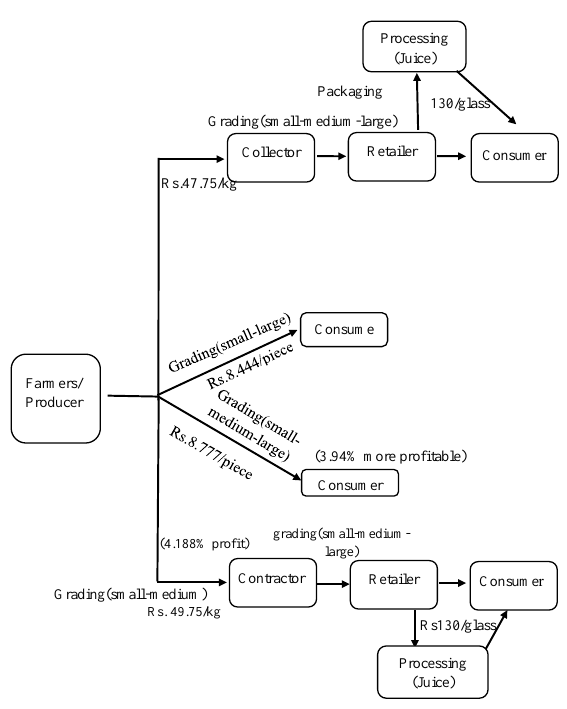
Table 1: Influence of stakeholders in price decision